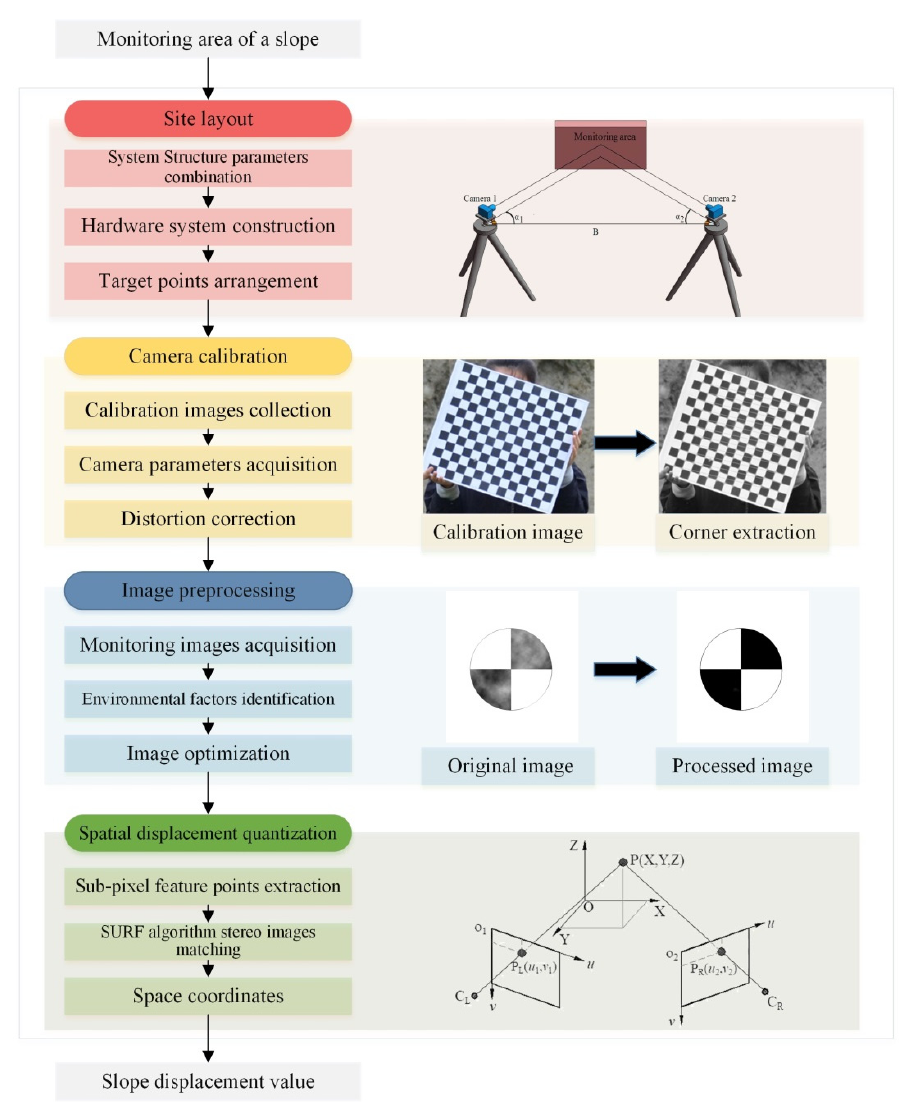
Figure 2. Slope deformation monitoring process based on binocular vision measurement system.